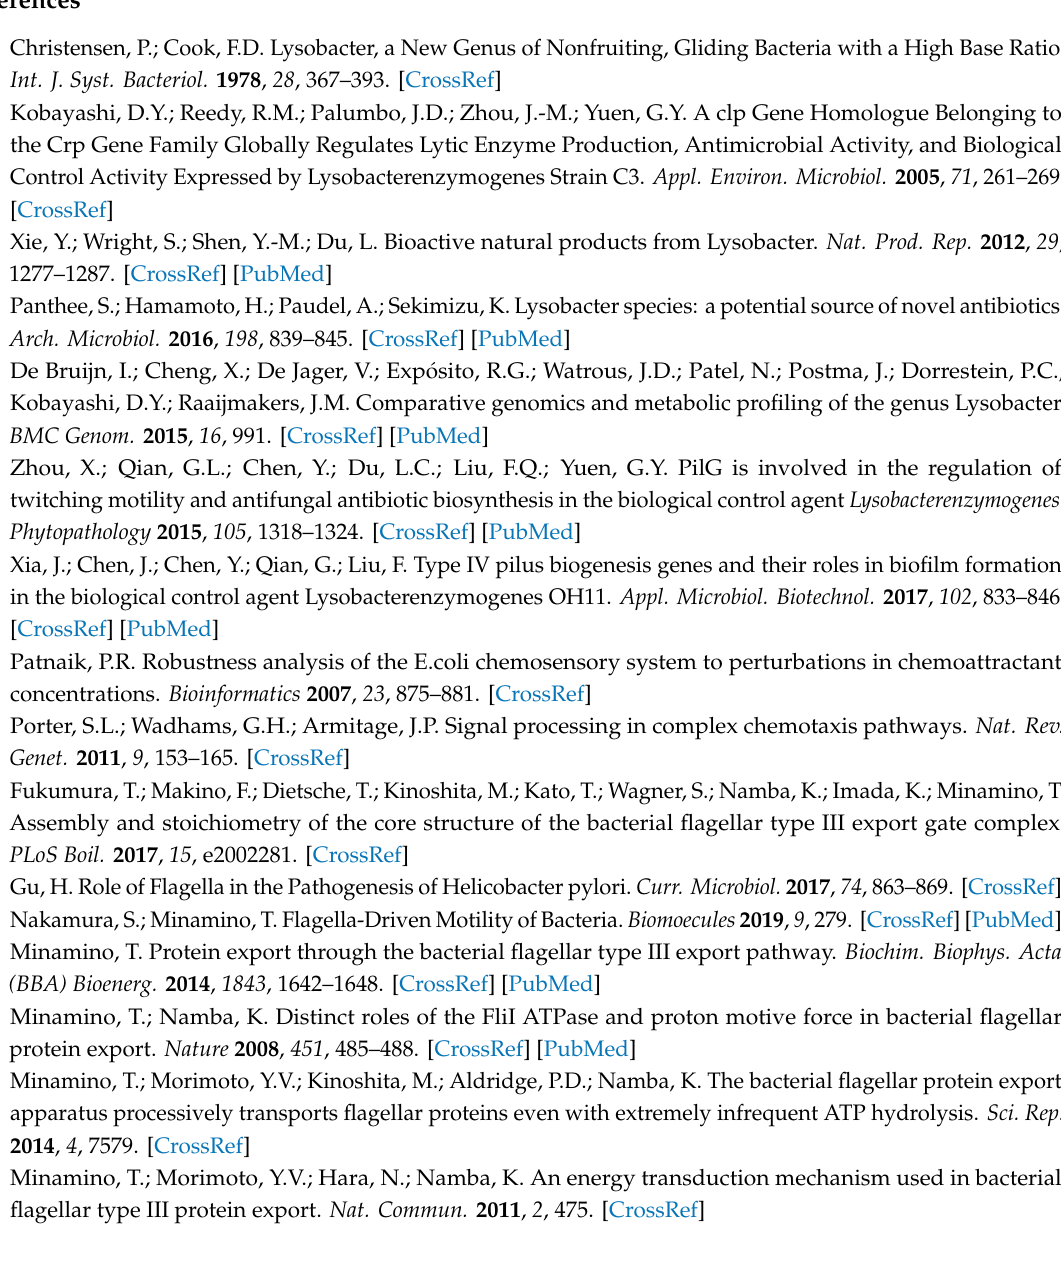
Figure S1: Cross-complementation of the L. enzymogenes FT3SS-like genes in the Salmonella mutants lacking the respective flagellar counterparts, Table S1: Strains and plasmids used in this study title, Table S2: Primers used in this